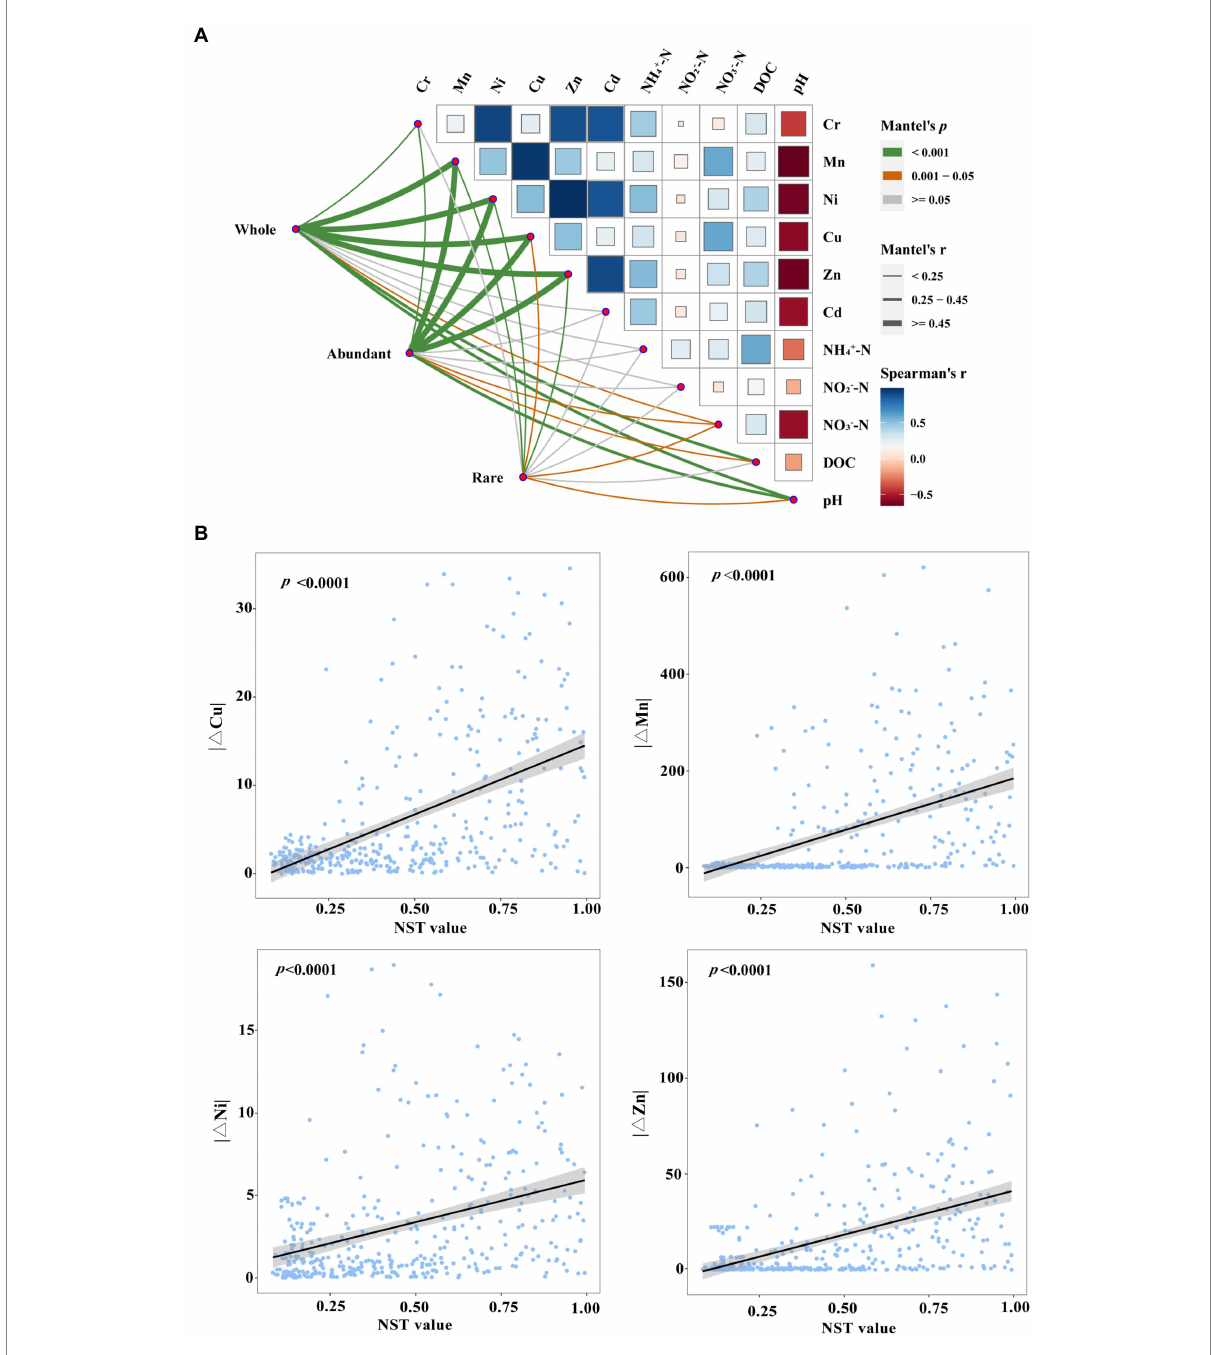
FIGURE 5 The environmental drivers DAMO bacterial communities. (A) Environmental drivers of the whole, abundant, and rare DAMO bacterial communities evaluated by Mantel test. Edge width corresponded to correlation coefficient and edge color indicated statistical significance. Pairwise comparisons of environmental variables with a color gradient represented Spearman correlation coefficients. (B) The linear relationship between NST values and metals (Cu, Mn, Ni, and